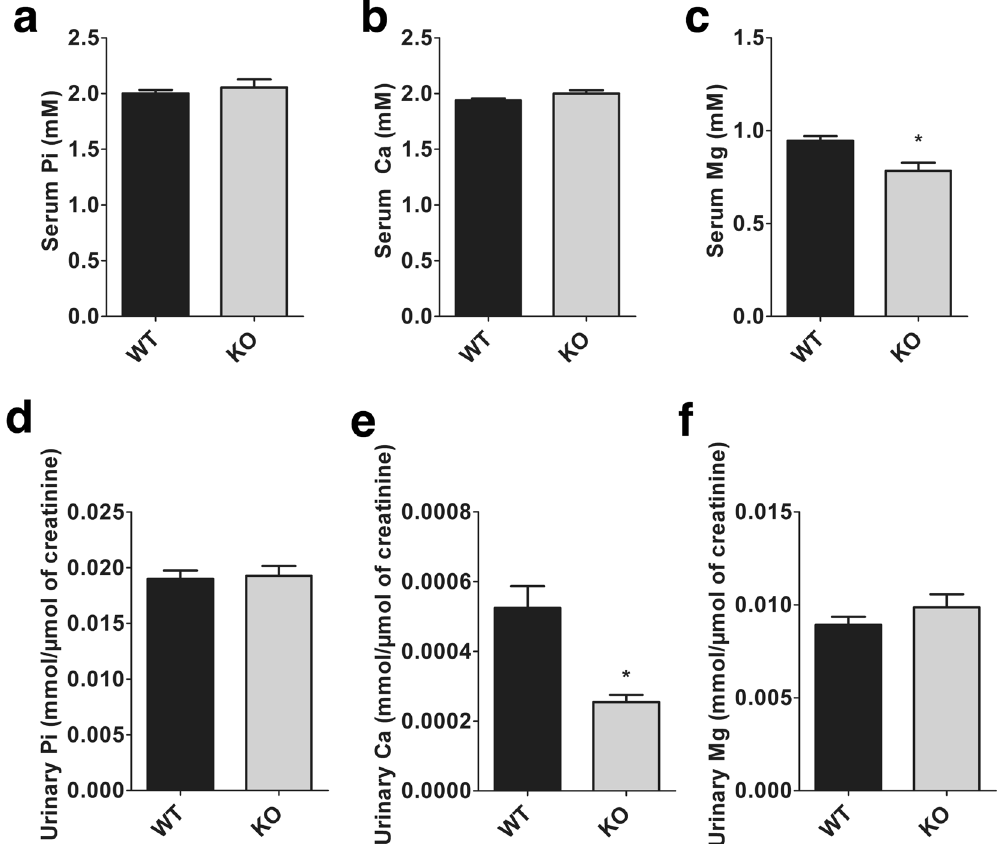
Figure 3. Blood and urinary phosphate (Pi), calcium (Ca) and magnesium (Mg) in WT and NCC KO mice. ( a – c ) Arithmetic means ± SEM (n = 9–12) of serum Pi ( a ), Ca ( b ) and Mg ( c ) in WT (black bars) and NCC KO mice (grey bars) under normal diet. ( d – f ) Arithmetic means ± SEM (n = 9–12) of urinary Pi ( d ), Ca ( e ) and Mg ( f ) normalized with creatinine in WT (black bars) and NCC KO mice (grey bars) under normal diet. * (p < 0.05) indicates significant difference from WT